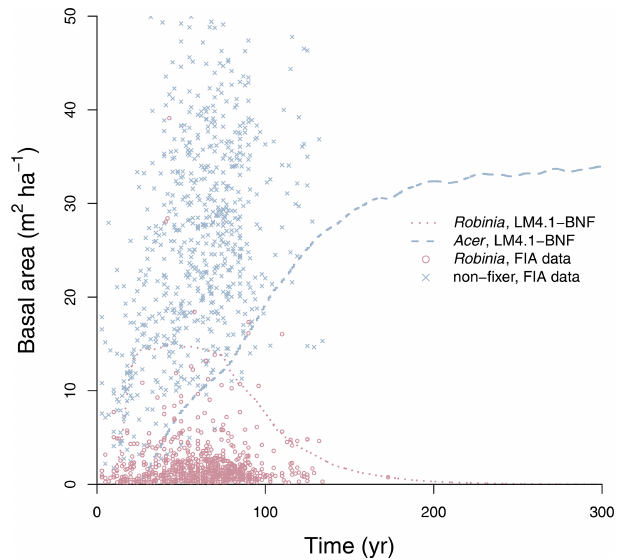
Figure D9. Simulated absolute basal area of Acer and Robinia over time compared to FIA data (in North Carolina). Simulated data are trees with dbh > 12 . 7cm to reflect the dbh range of FIA data. FIA data of all non-fixing trees are aggregated to represent Acer . Each point represents an FIA plot.